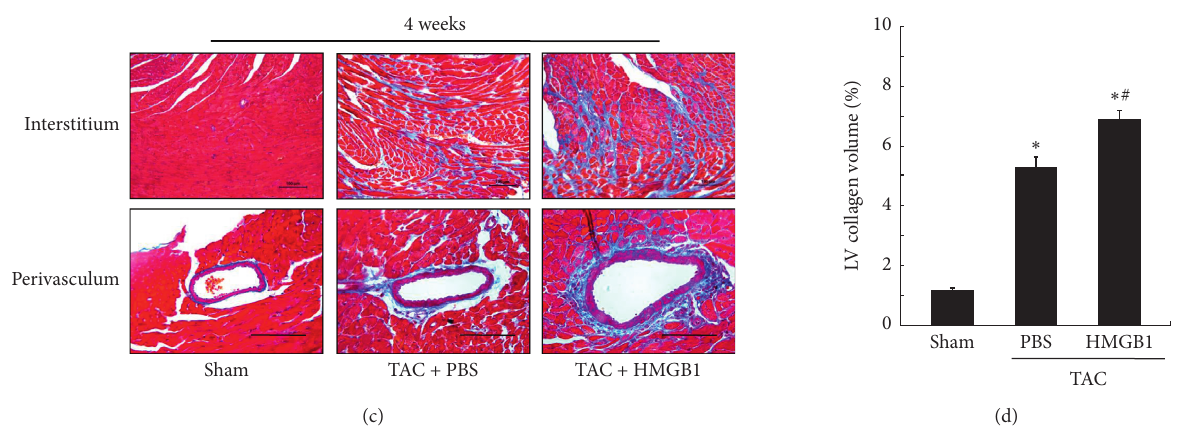
Figure 4: Echocardiography measurement and Masson staining at 4 weeks after intervention. (a, b) Echocardiography measurement of LV ejection fraction (LVEF) and LV fractional shortening (LVFS). TAC: transverse aortic constriction; HMGB1: high-mobility group box 1. (c) Representative images of the whole hearts after TAC (scale bars 100 μ m). Values are expressed as mean ± S.E.M. n > 8 per group in each group. ∗ P < 0 . 01 versus control.